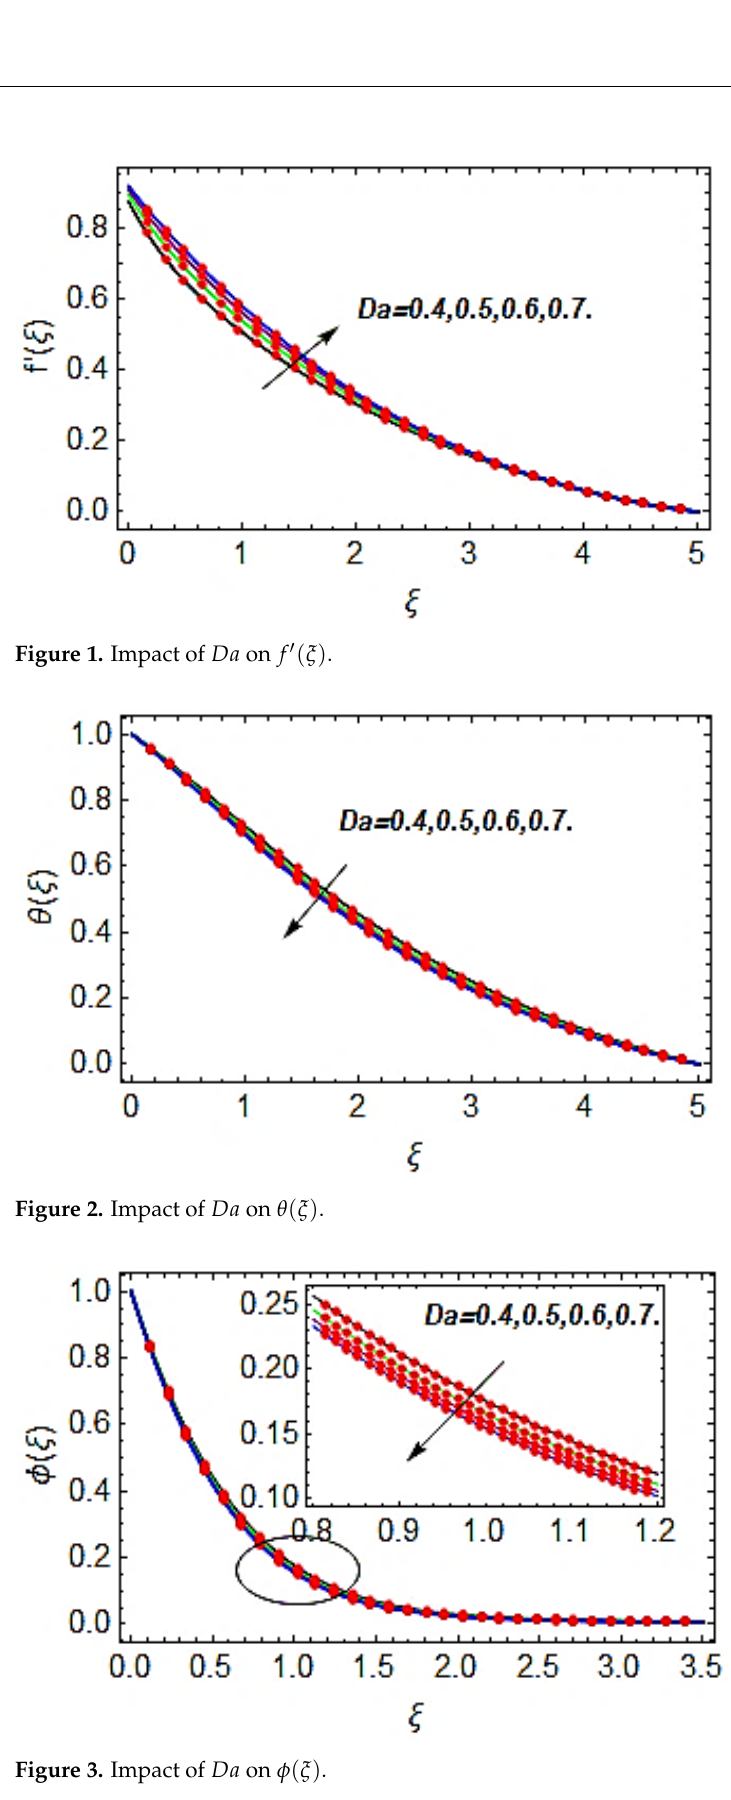
Figure 3. Impact of Da on φ ( ξ )